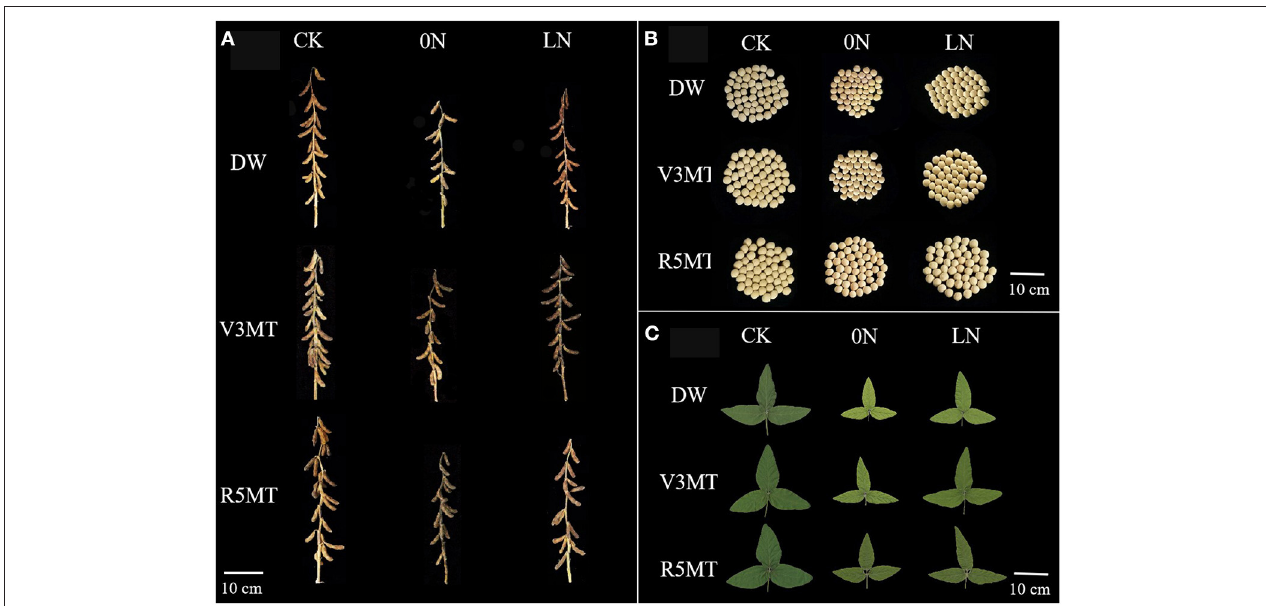
FIGURE 12 | Effects of exogenous melatonin (V3 and R5) on the morphology of plant (A) and seed (B) at harvest, and the functional leaf morphology after 12 days of treatment (C) . CK, control nitrogen; 0N, zero nitrogen; LN, low nitrogen; DW, distilled water; V3MT, melatonin application at V3 stage; R5MT, melatonin application at R5